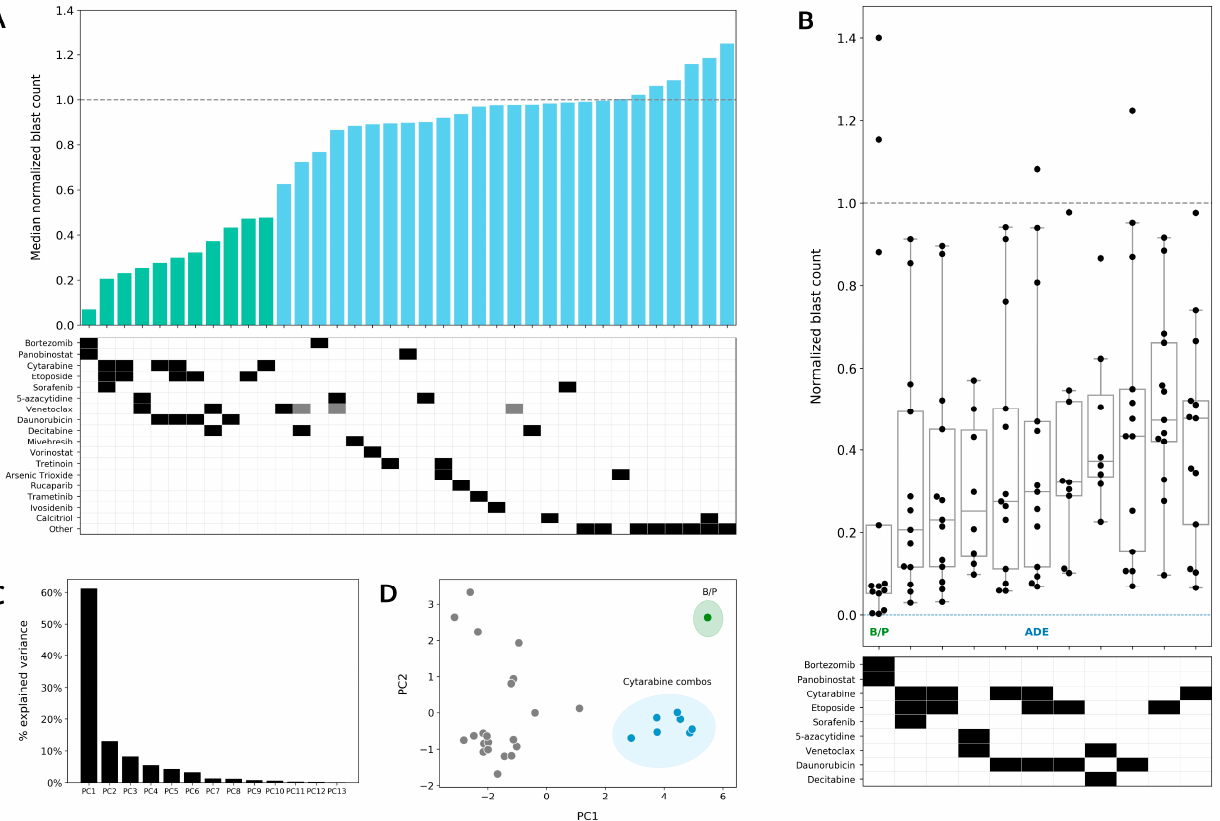
Figure 4. Bortezomib in combination with panobinostat shows greater sensitivity than ADE ex vivo. ( A ) Median normalized blast counts for 13 patients in response to 37 conditions assayed ex vivo. Conditions are ordered from most to least sensitive starting from the left. Green bars highlight the 11 most sensitive conditions in the DSP. The others indicate the following conditions from left to right: enasidenib, gilteritinib, quizartinib, sunitinib, crenolanib, dexamethasone, dexamethasone/calcitrol, and midostaurin. Gray boxes indicate lower drug concentrations. ( B ) Box plot of the top 11 treatments. Normalized blast counts >1.4 are shown as 1.4. B/P, bortezomib/panobinostat; ADE, cytarabine/daunorubicin/etoposide. ( C ) Percentage of variation in the DSP explained by principal component (PC). ( D ) PC1 vs. PC2 principal component analysis plot to identify clustering of conditions that account for variance in ex vivo drug sensitivity. B/P is shaded in green. Conditions including cytarabine are shaded in blue.